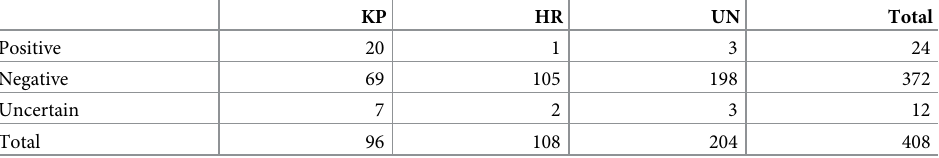
Table 1. A summary of amplified samples across the three stream categories: Known Population (KP), Historical Record (HR), Unknown (UN). KP HR